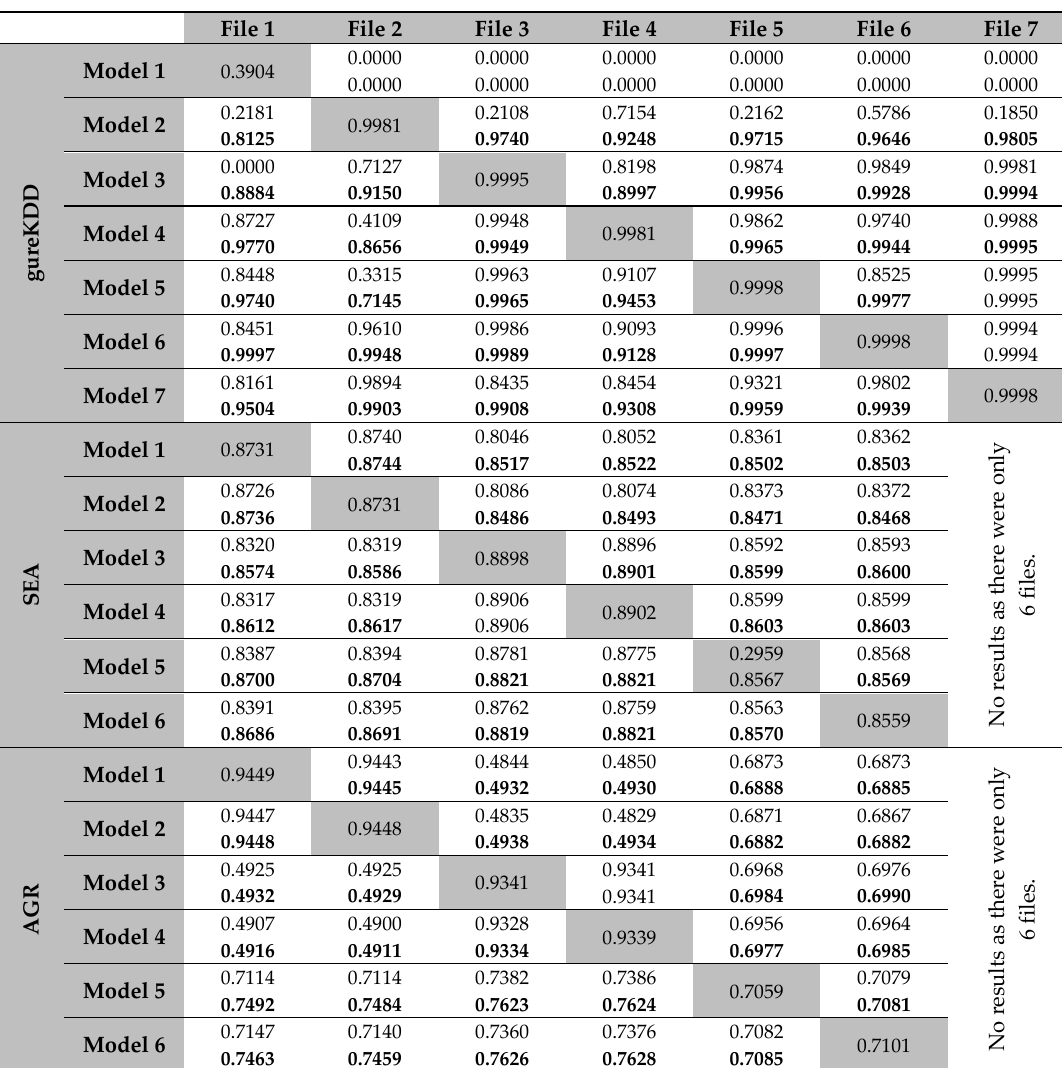
Table A1. C5.0 model’s performance on di ff erent datasets with various e ff ects (before and after Table 1. C5.0 model’s performance on different datasets with various effects (before and after threshold adaptation). threshold